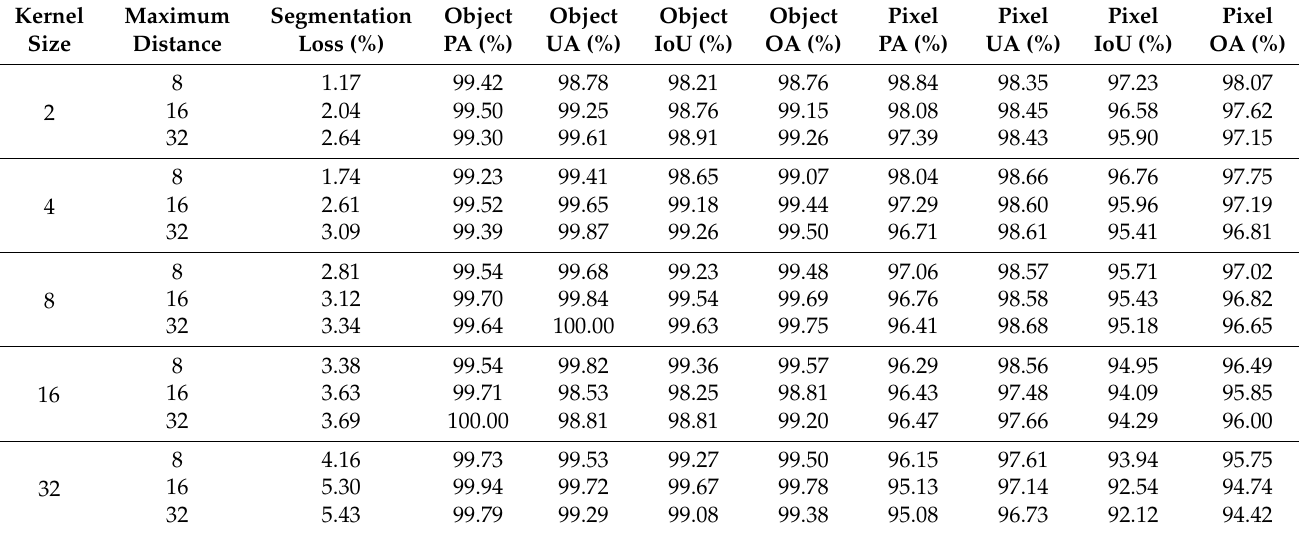
Table 3. Performance evaluation of snow mapping with different segmentation parameters using random forest (RF) over the study area in Bome County (excluding the training zone).